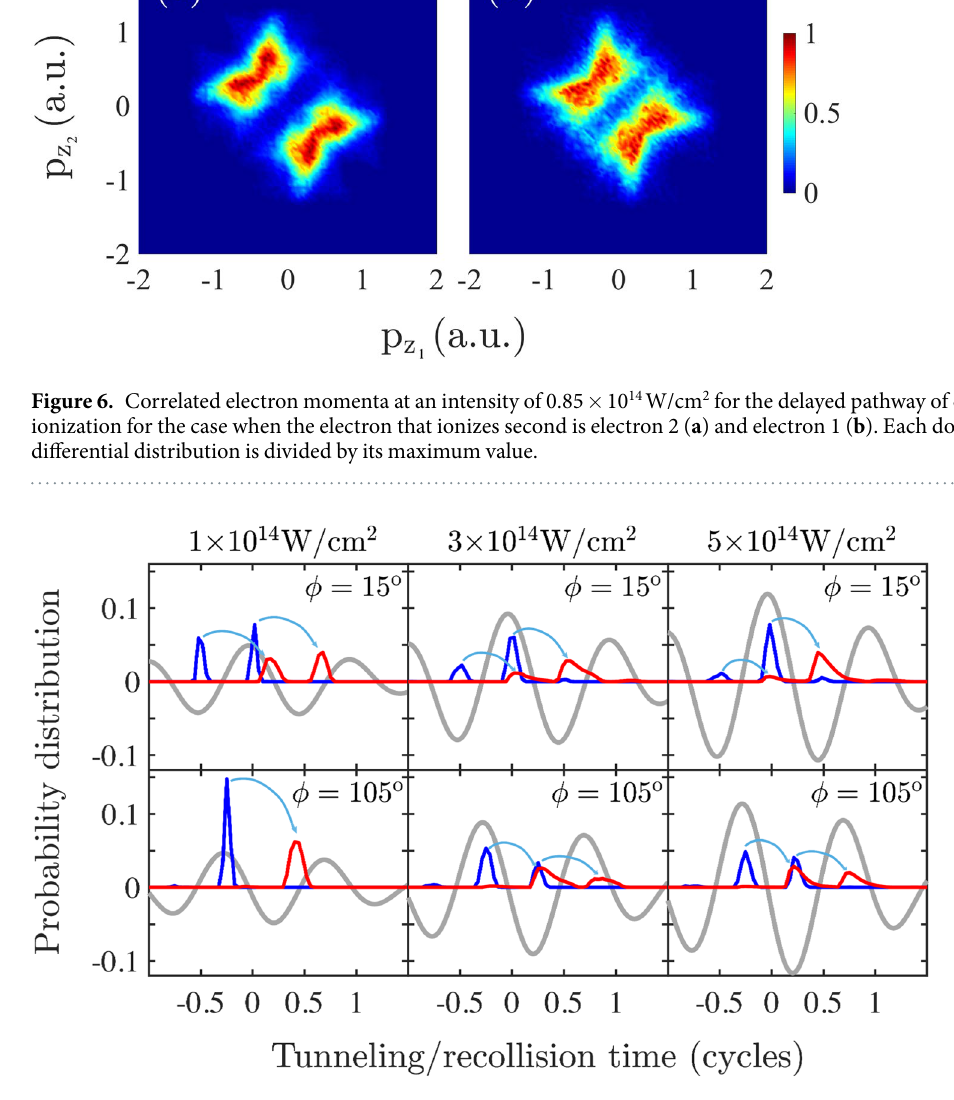
Figure 7. Probability distribution of the tunneling time t 0 of electron 1 (blue line) and of the recollision time t rec (red line) for intensities 10 14 W/cm 2 , 3 × 10 14 W/cm 2 and 5 × 10 14 W/cm 2 and for two different CEPs, φ = 15° and φ = 105°, for each intensity. Similar results hold for all other CEPs. Grey line denotes the laser field. The light blue arrows indicate the mapping of a tunneling-time peak to a recollision-time